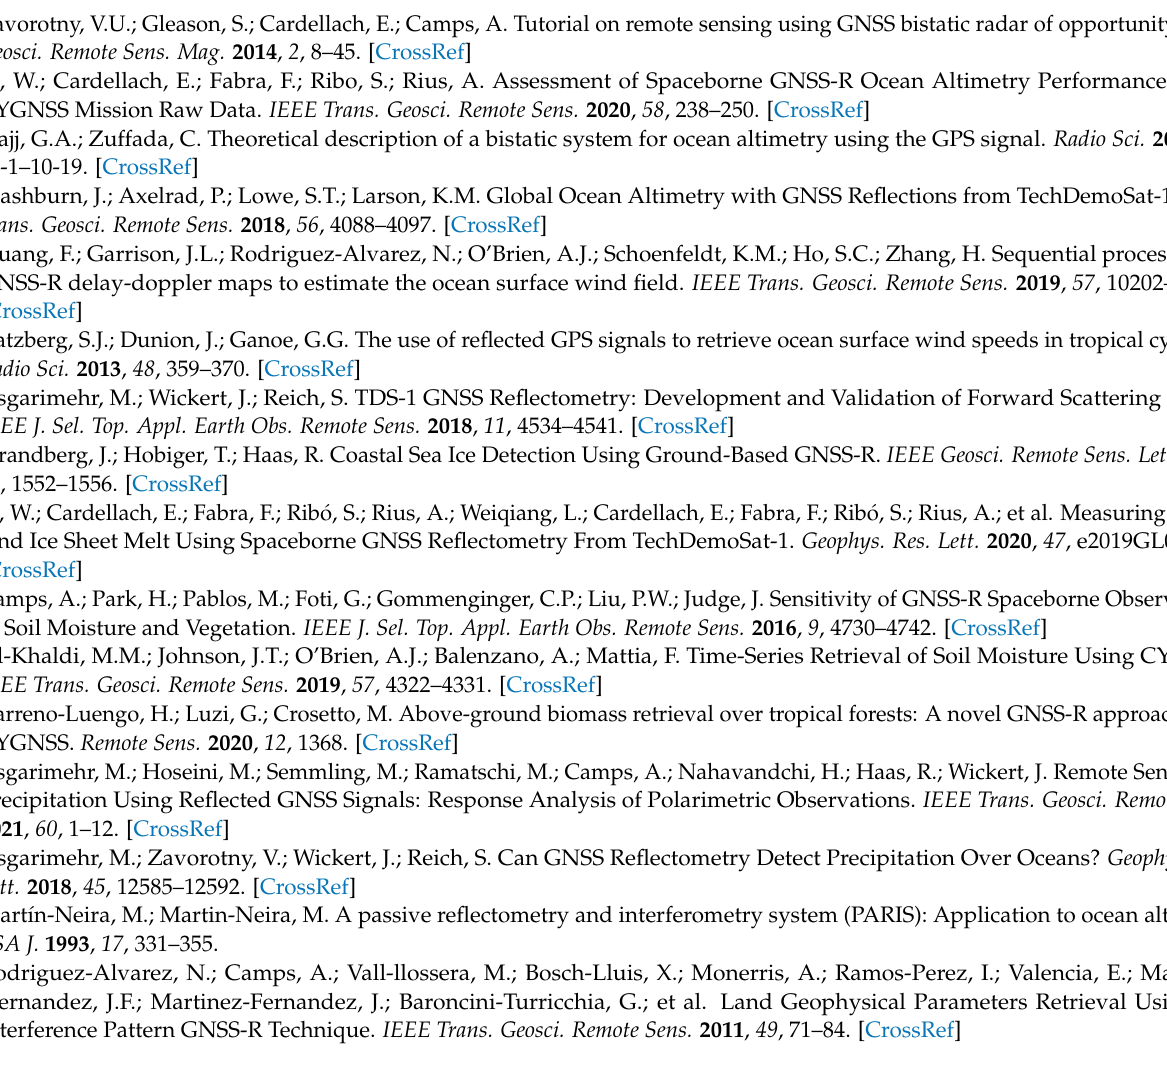
For different orbital height systems, dedicated coefficients for Glonass, Galileo, and Beidou (MEO) systems can achieve a similar precision (within 1.5 km) as the GPS system shown in Figure A4 in the fastest